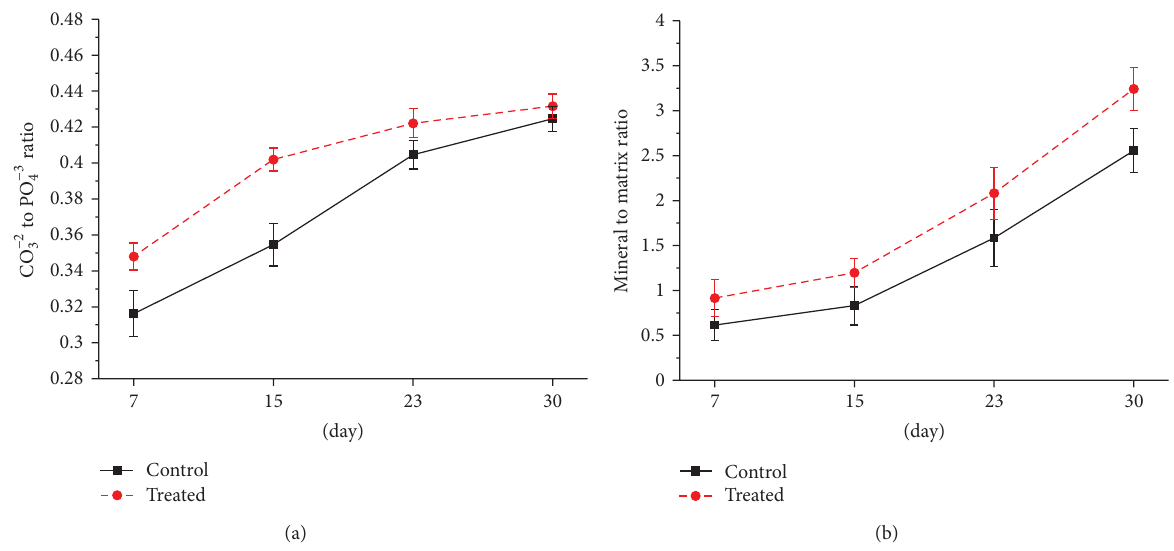
F 3: Scatter plot of the ratios of bone components measured as Raman band area ratios. (a) Carbonate-to-phosphate ratio